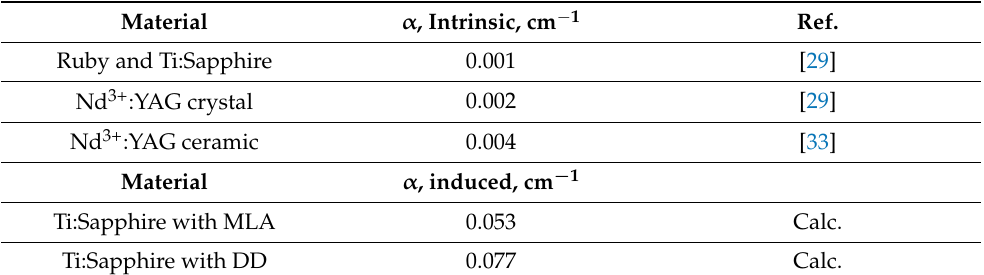
Table 3. Scattering coefficients of optical materials. Adopted with permission from ref. [18]. Copy- right 2019 © The Optical